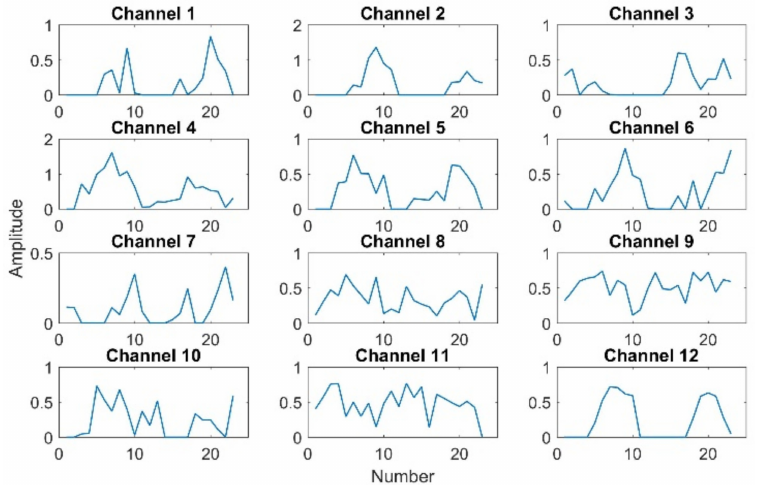
Figure 18. Output of the first pooling